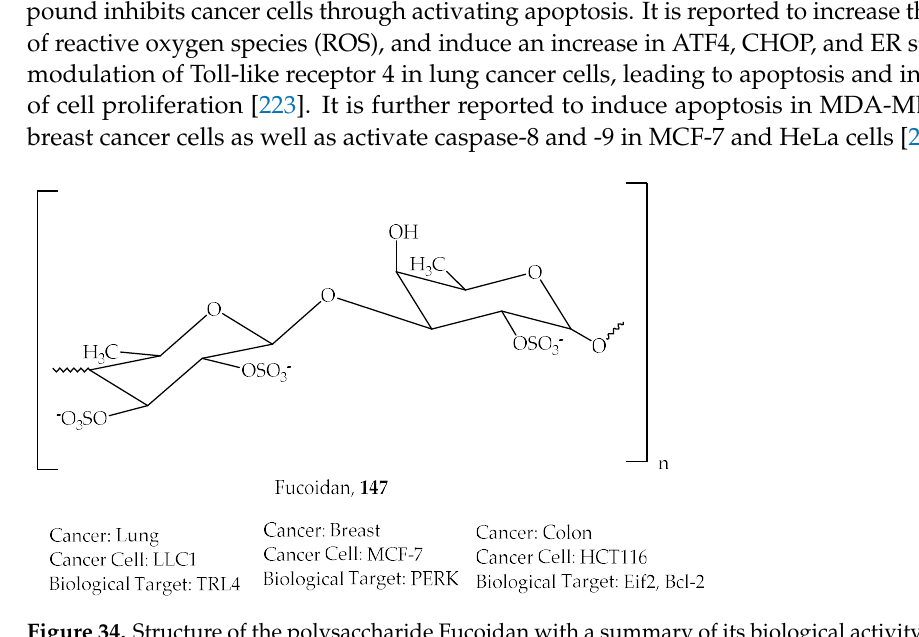
Figure 34. Structure of the polysaccharide Fucoidan with a summary of its biological activity towards selected cancer targets.